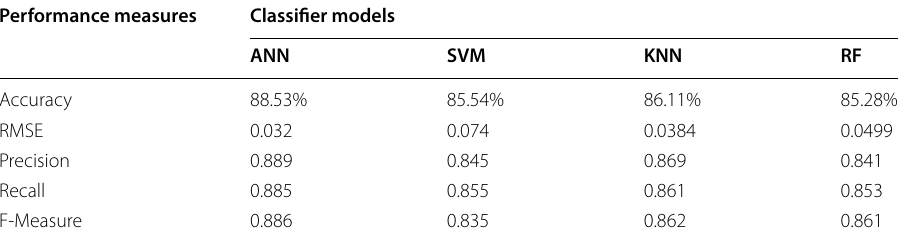
Table 4 Performance of ML models on English dataset Performance measures